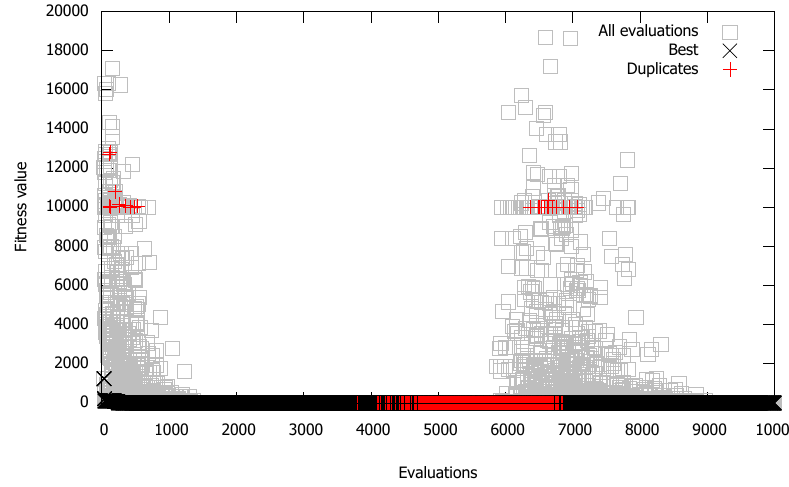
Figure 4. One run of the ABC algorithm on the Sphere problem for n = 2 and Pr =